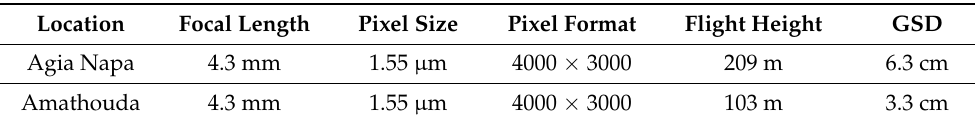
Table 3. Camera specification, flight height and Ground Sampling Distance (GSD) for Agia Napa and Amathouda measurement